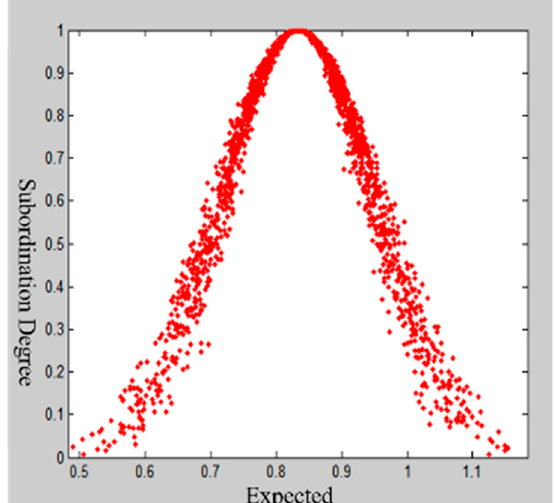
Figure 9. E xpert scoring cloud model restoration chart for the third time. Figure 9. Expert scoring cloud model restoration chart for the third